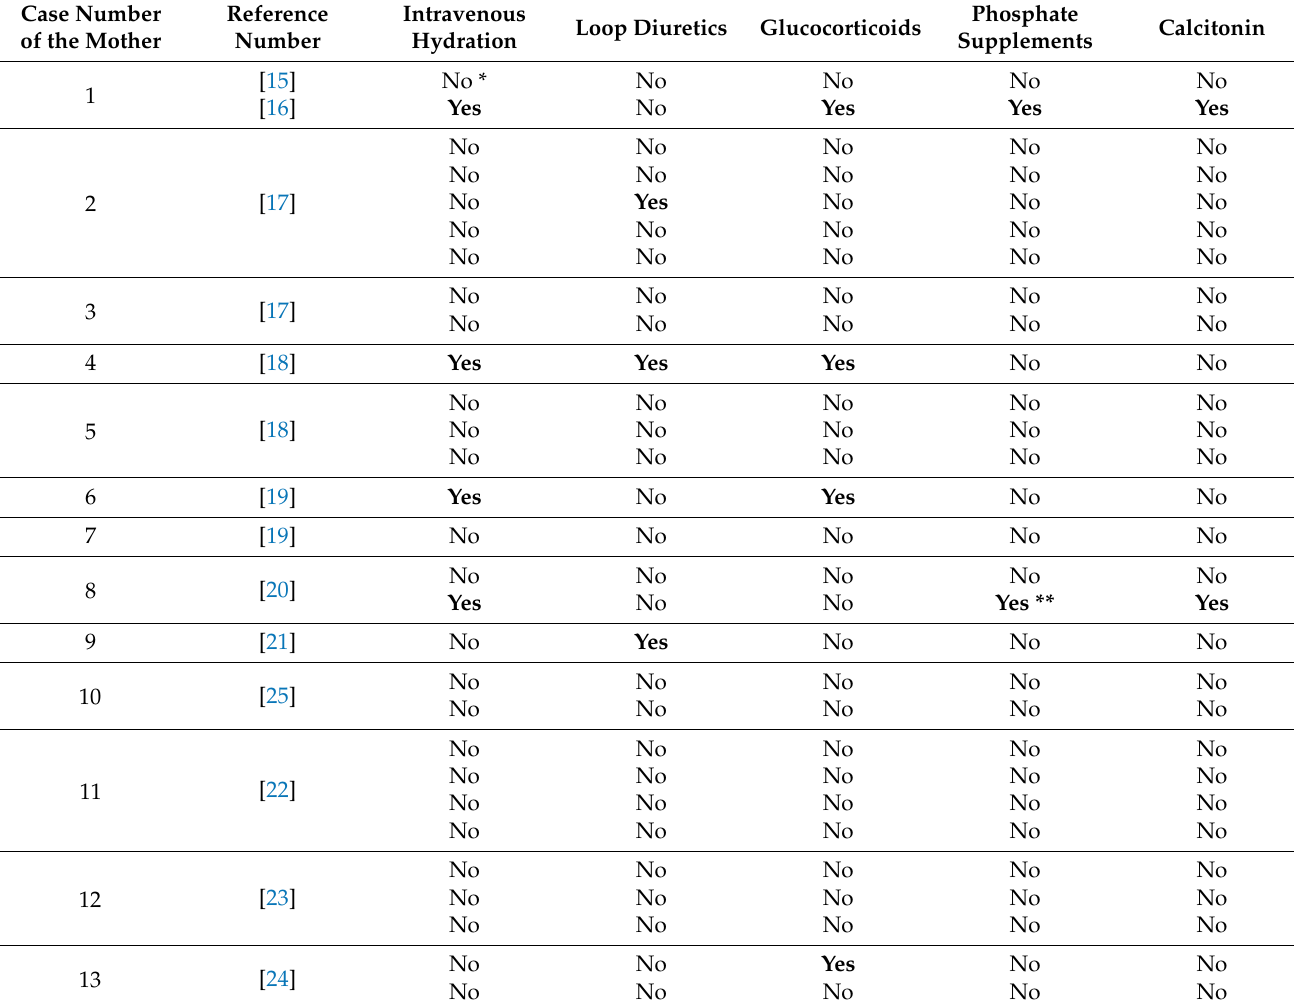
Table 3. Specific drug treatments of women with pathogenic CYP24A1 mutations during